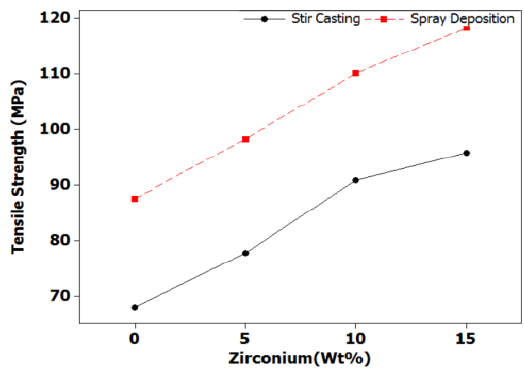
Figure 19. Tensilestrength (0.05% error) experimental plot at different processing techniques of Si-Al alloy matrix reinforced with ZrO 2 particulates for ( a ) 10% ( b ) 11% ( c ) 12% ( d ) 13 wt. % Si.